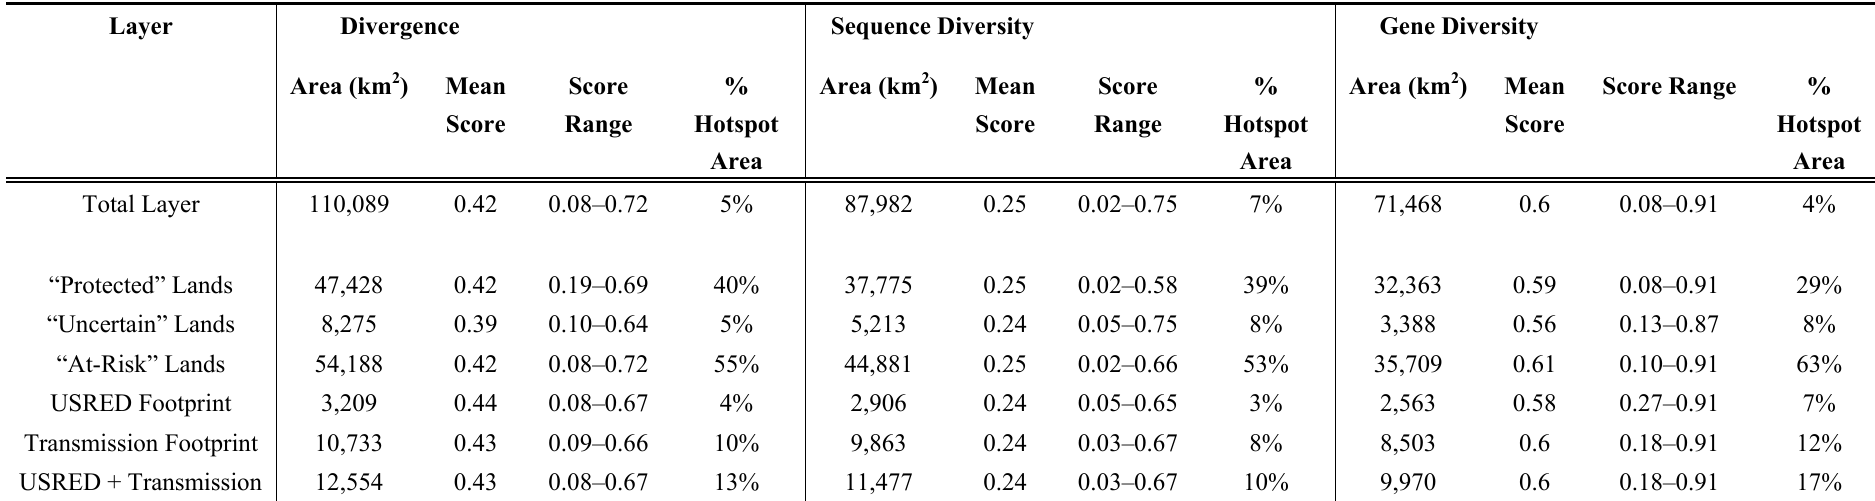
Table 3. Overlap between divergence and diversity landscapes, land status, proposed utility scale renewable energy development (USRED), and transmission